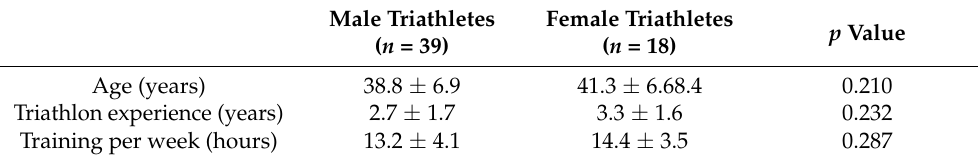
Table 1. Characteristics of